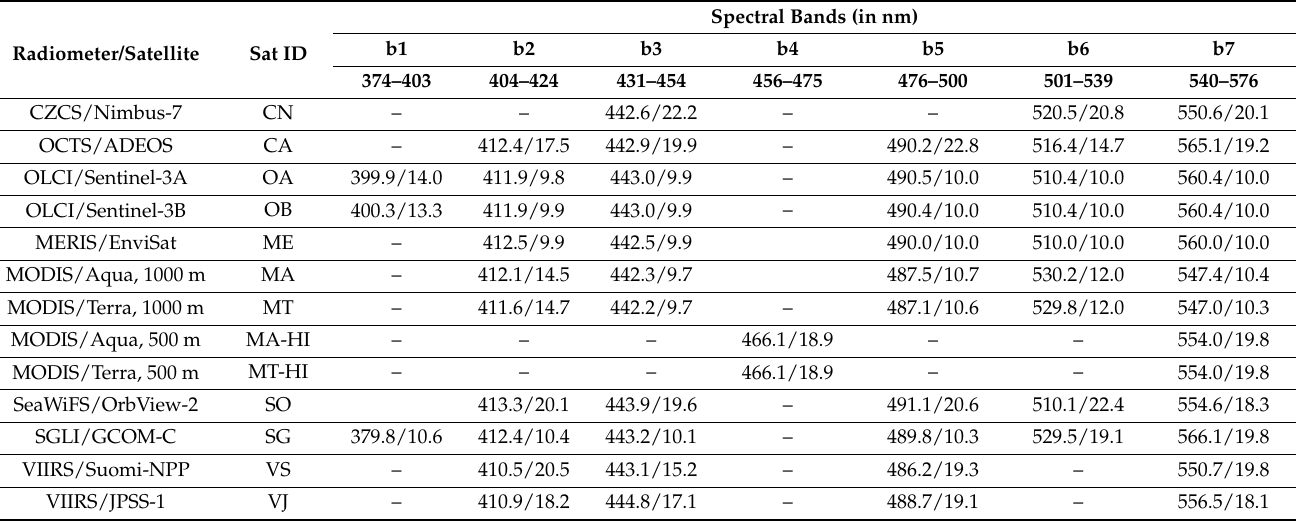
Table 1. Spectral bands in the 374–576 nm range available on analyzed satellite radiometers. Each cell contains information structured as λ center (nm)/ FWHM (nm).